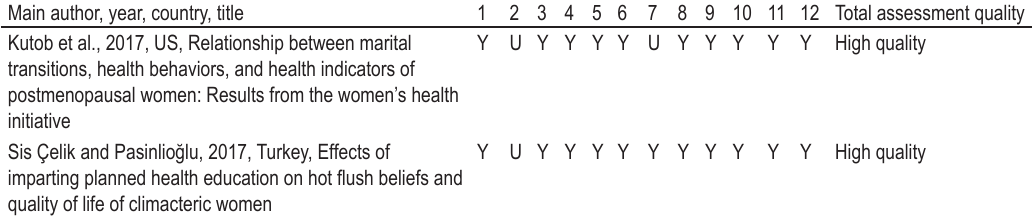
TABLE 4. Quality assessment of the included studies with cohorts design